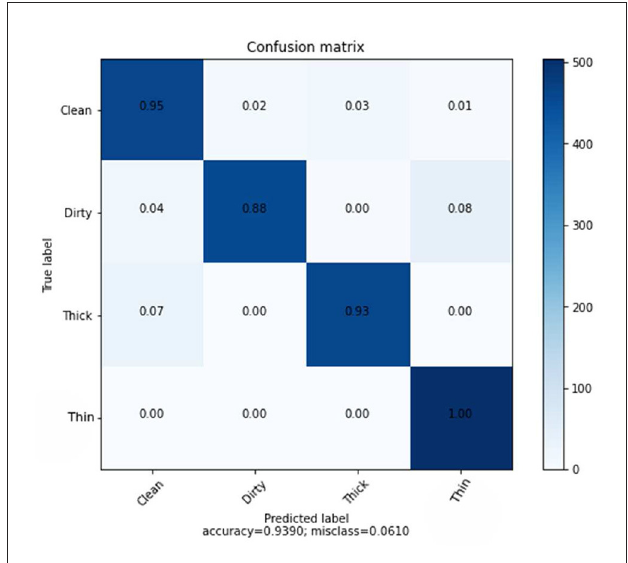
FIGURE10 Confusion matrix of combined features using KNN.